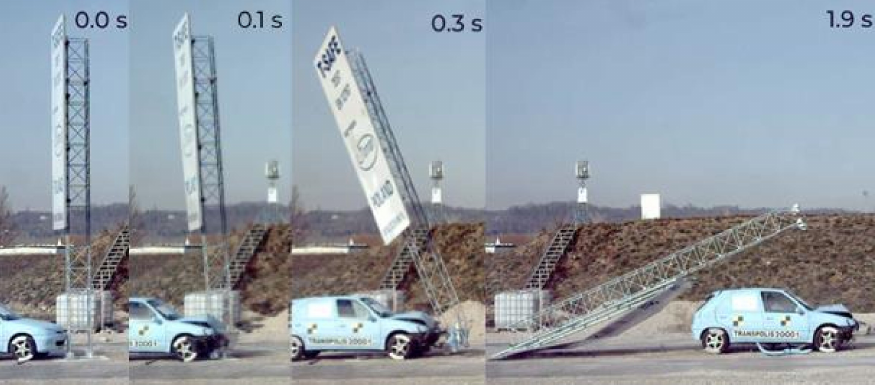
Figure 11. The result of a crash test with T03 mast at 35 km/h velocities. The recorded linear acceleration and angular velocity values during testing of T03 mast at 35 km/h velocities are presented in Figures 12 and 13. The data collected during experimental tests were weighed with a digital low-pass Butterworth filter of fourth-order with a 3 dB cut-off frequency equal to 300 Hz (Channel Frequency Class 180) and 100 Hz (CFC 60). Figures 11 and 12 present raw and weighted